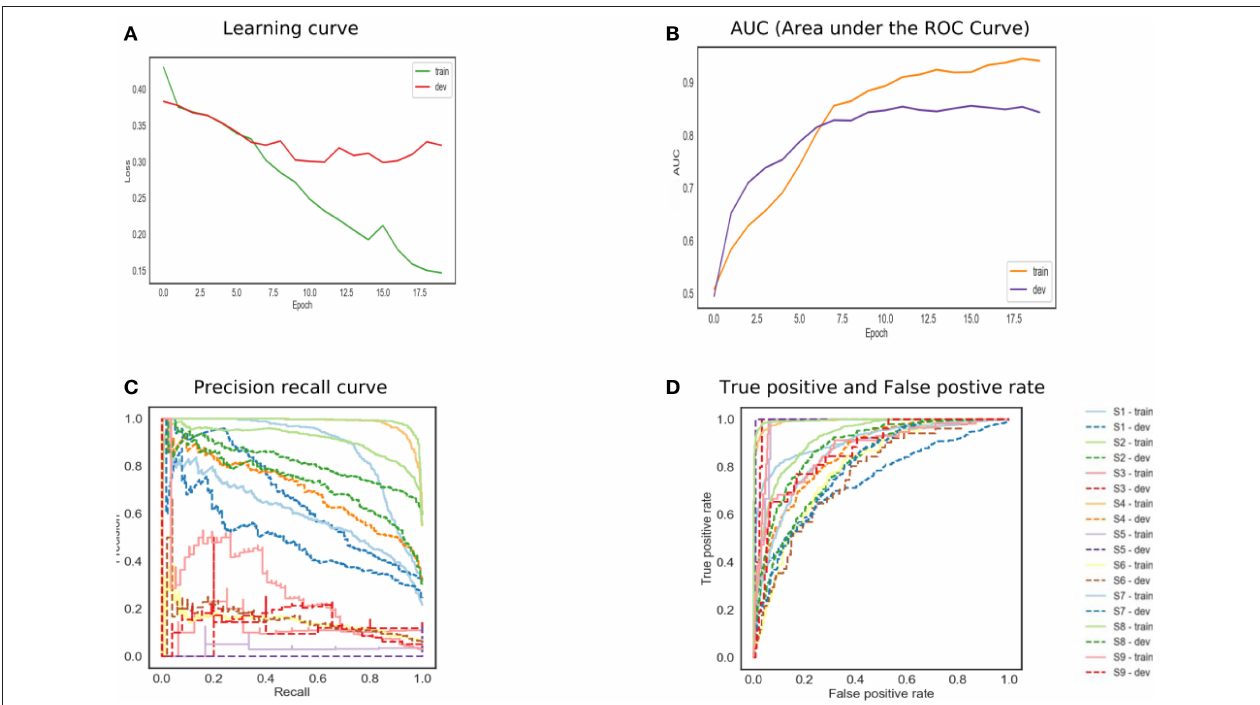
FIGURE 6 | The performance of bidirectional Long Short-Term Memory (LSTM) with attention.